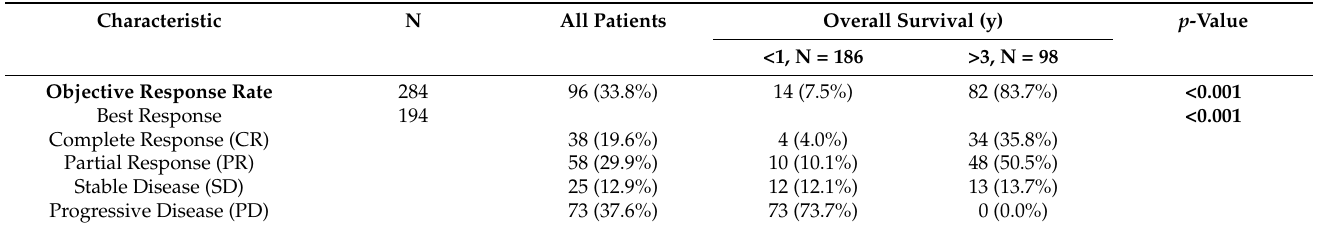
Percentages reported based on total number of best responses known in each survival